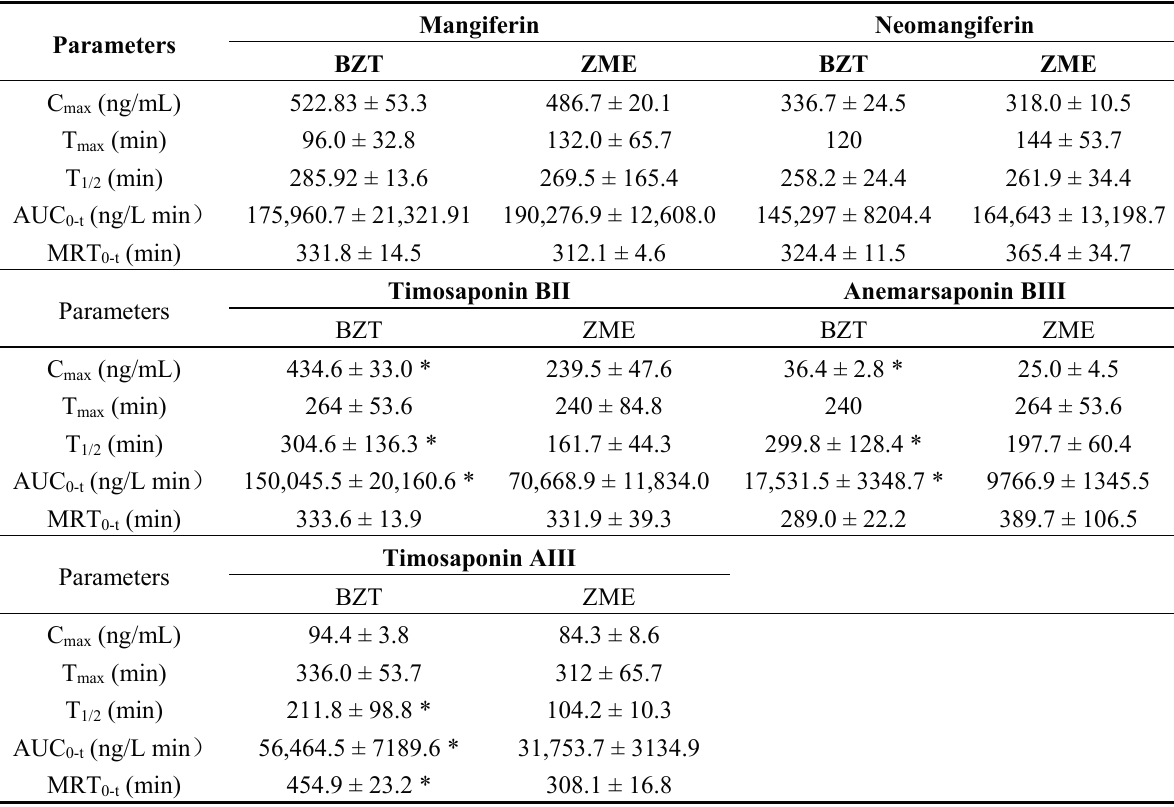
Table 4. Pharmacokinetics parameters of analytes in male SD rat following oral administration of BZT and ZME (mean ± SD, n =